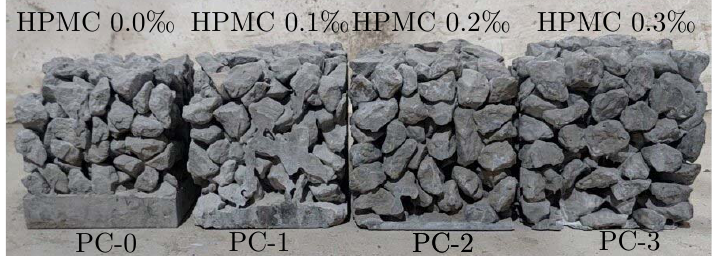
Figure 4. Hardened porous concretes with different dosages of HPMC.